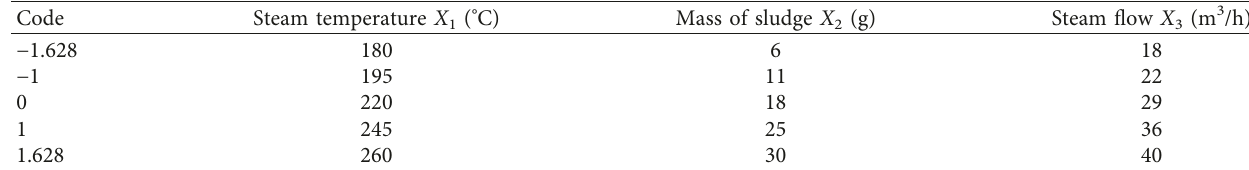
Table 1: Experimental factors and